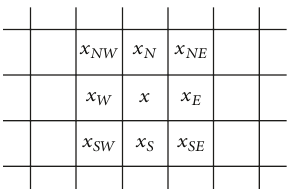
Figure 2: Texture context of the pixel 𝑥 to be sharpened.